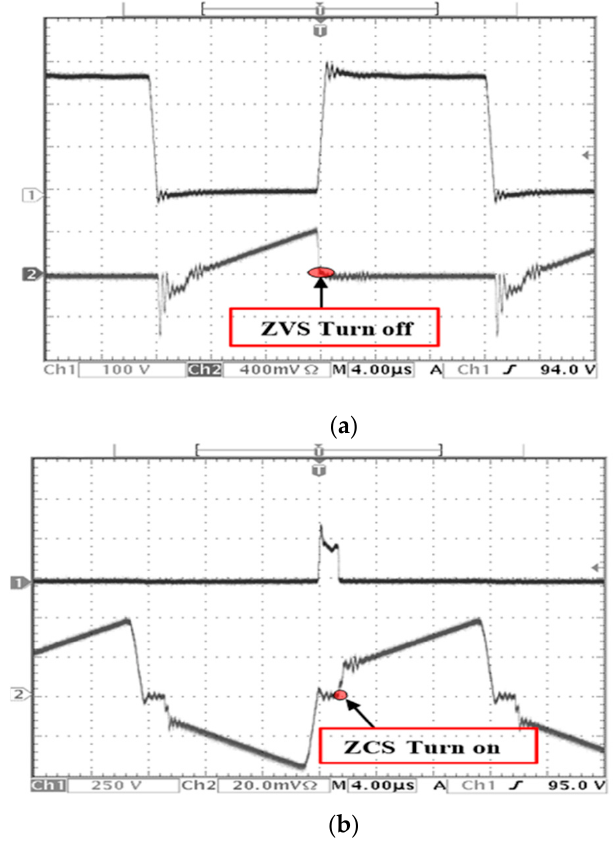
Figure 10. Operation waveform by experiment in the case of Rated output (duty factor = 0.9). ( a ) Upper: primary-side switch voltage V s1 : 100 V / div. Bottom: primary-side switch current i s1 : 20 A / div. ( b ) Upper: secondary-side switch voltage V s5 : 250 V / div, time scale: 4 µ s / div. Bottom: transformer secondary-side current i 2 : 10 A / div